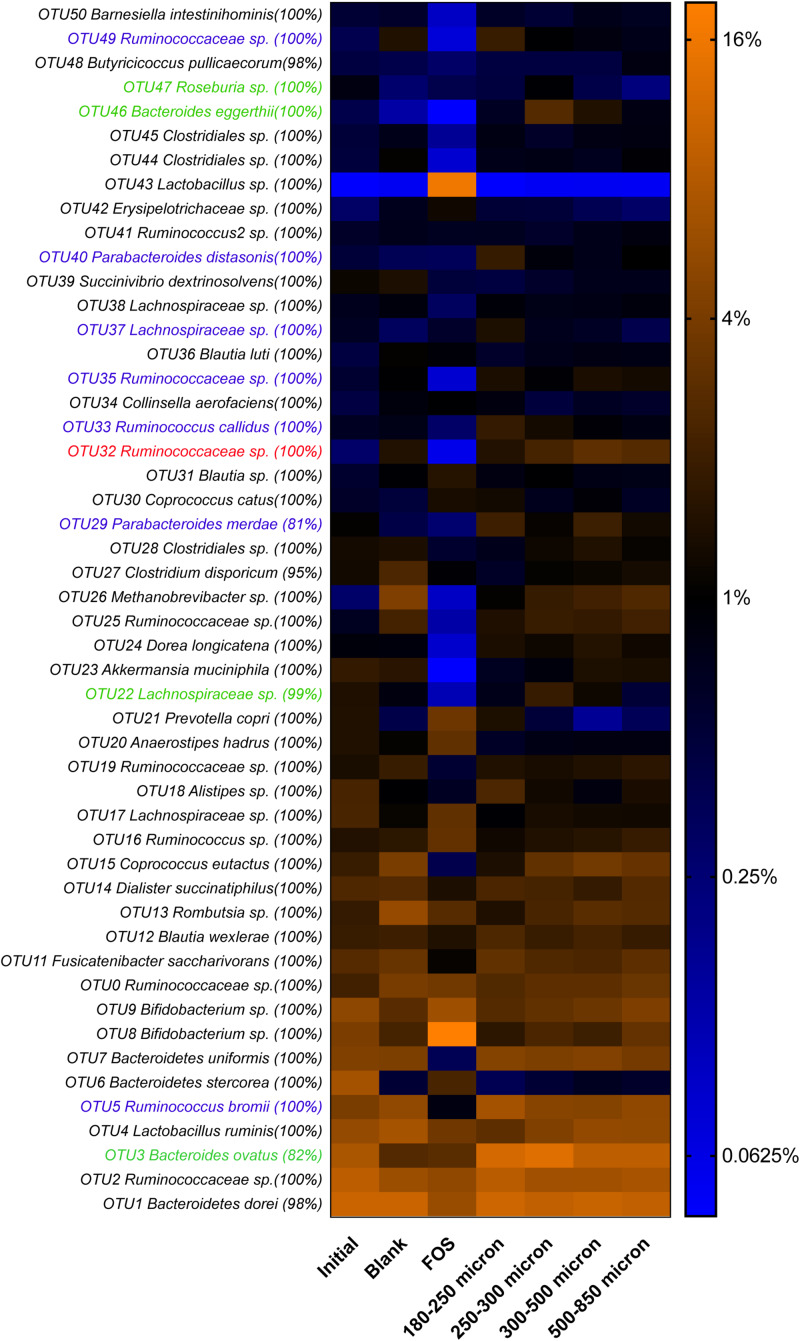
Relative abundances of top 50 OTUs arising in fermentation of maize bran particles diverging in size. OTU abundances were log2-transformed for display in the heatmap. Percentage values represent the fraction of reads within an OTU matching the assigned taxonomy of the OTU. Blank represents a no-carbon substrate control, and fructooligosaccharide (FOS) is a fast-fermenting positive control.